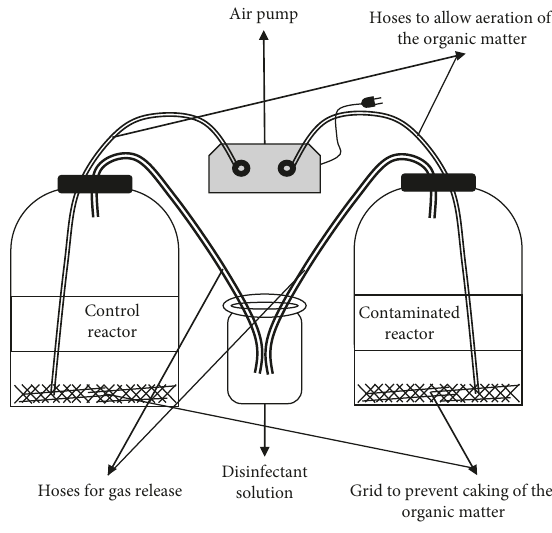
Figure 1: Composting reactor